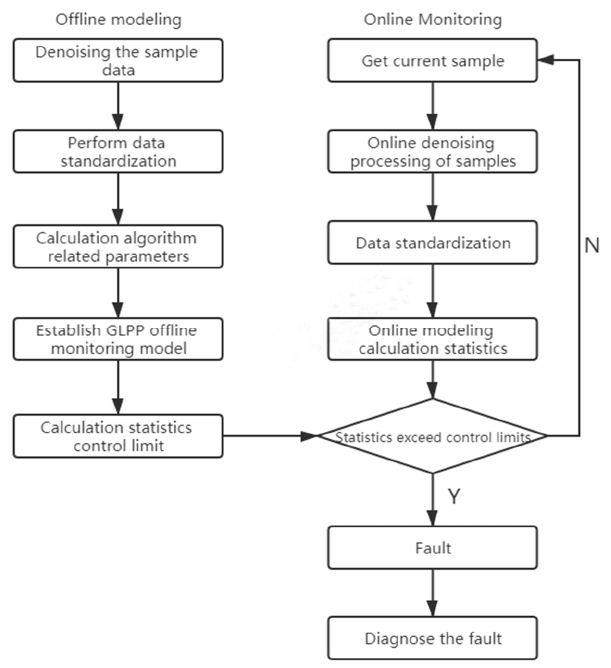
Figure 2. Sliding window wavelet denoising-global local preserving projections (SWWD-GLPP) flow chart.